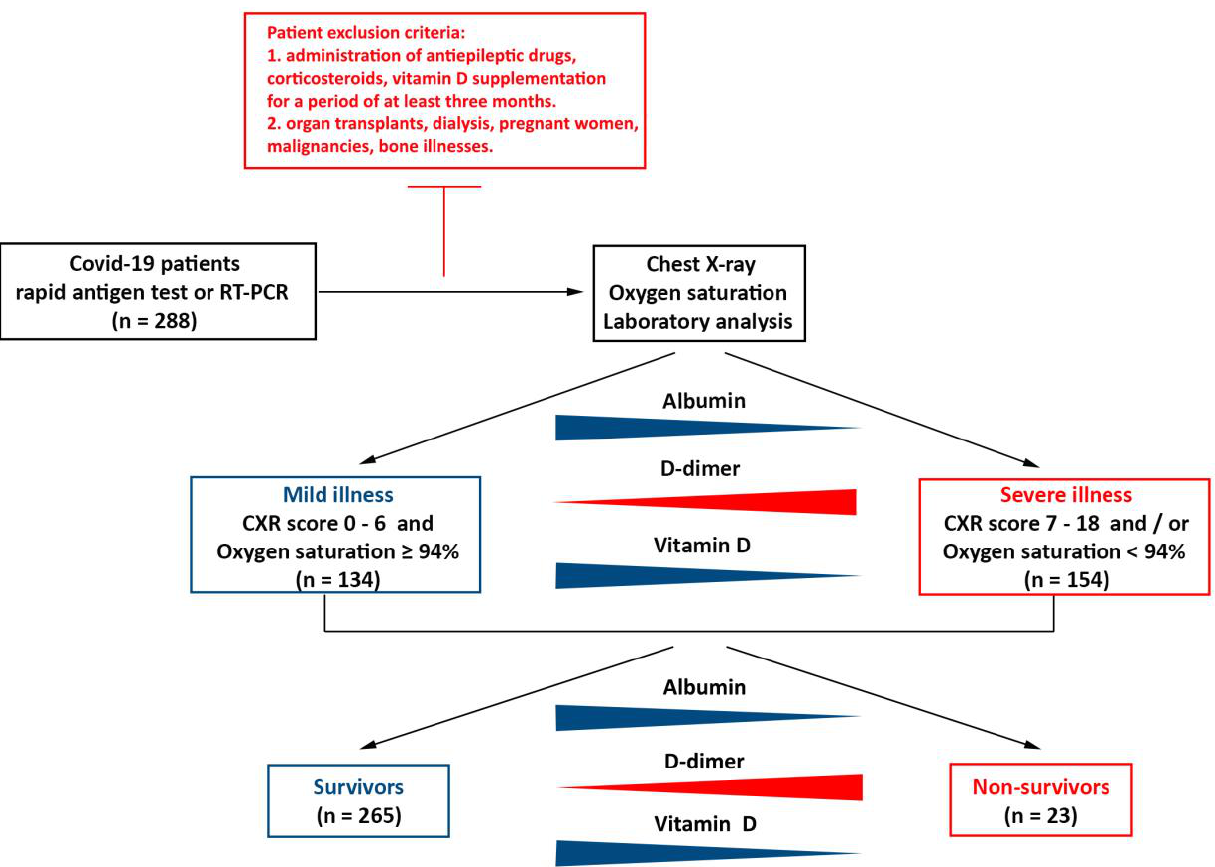
Figure 1. Graphic representation of the entire workflow of the study. (chest X-ray (CXR), real-time reverse transcription (RT-PCR))